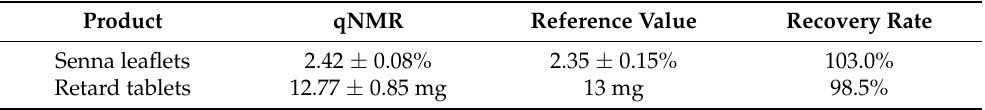
Table 3. Repeatability, intra-day, and inter-day precision of the total sennoside content (calculated as sennoside B) and sennosides A, B, and A 1 . Results are given in % weight of dried plant material; standard deviation is indicated in